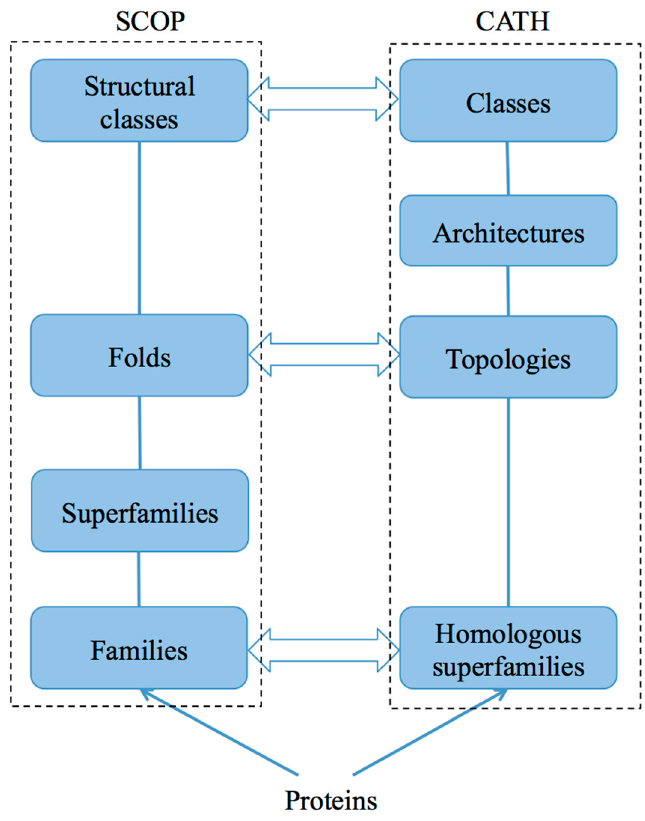
Figure 1. Architectures of two protein databases: SCOP and ACTH.